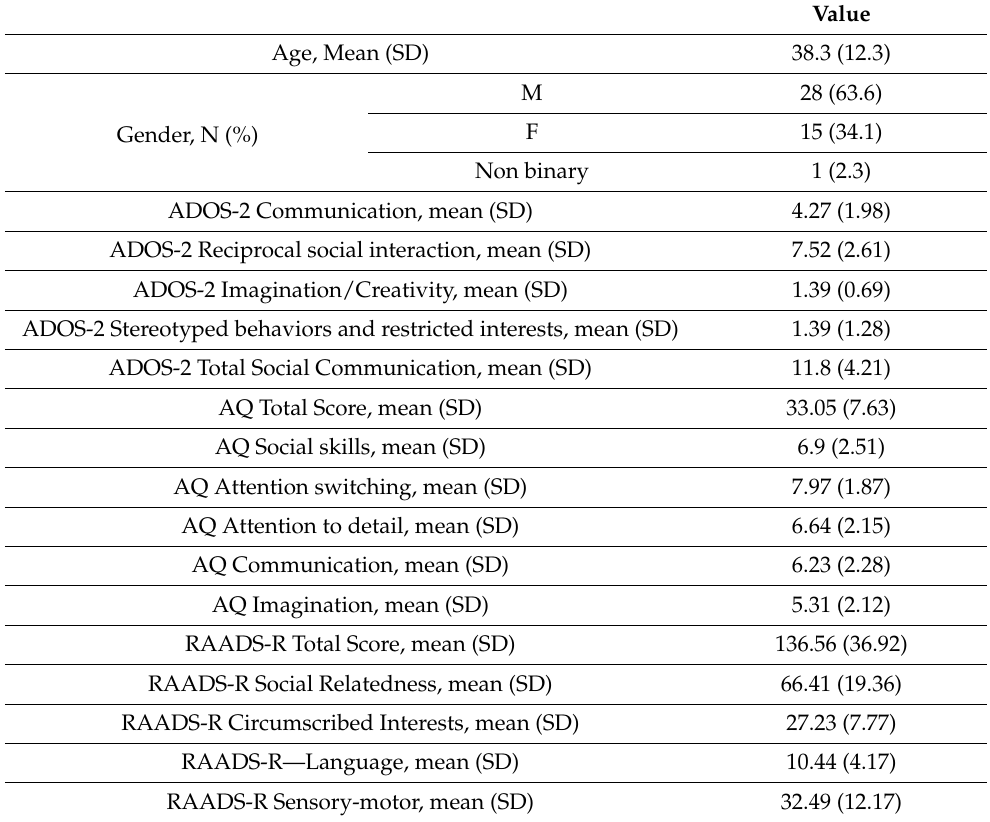
Table 1. Demographic features of our sample of individuals with HF-ASD.